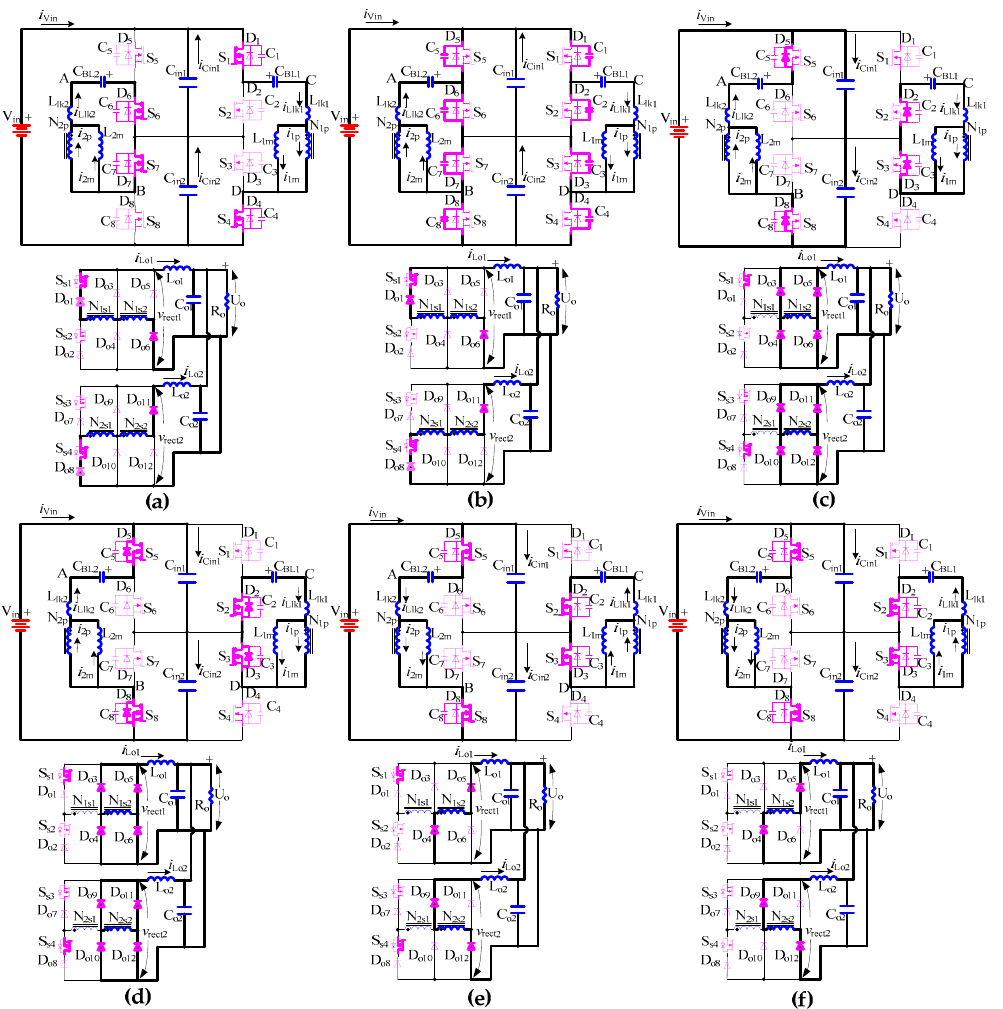
Figure 4. Operation stages of the secondary modulation: ( a ) stage 1; ( b ) stage 2; ( c ) stage 3; ( d ) stage 4; ( e ) stage 5; ( f ) stage 6. Table 1. Switching scheme in the first half switching period (secondary side modulation mode).